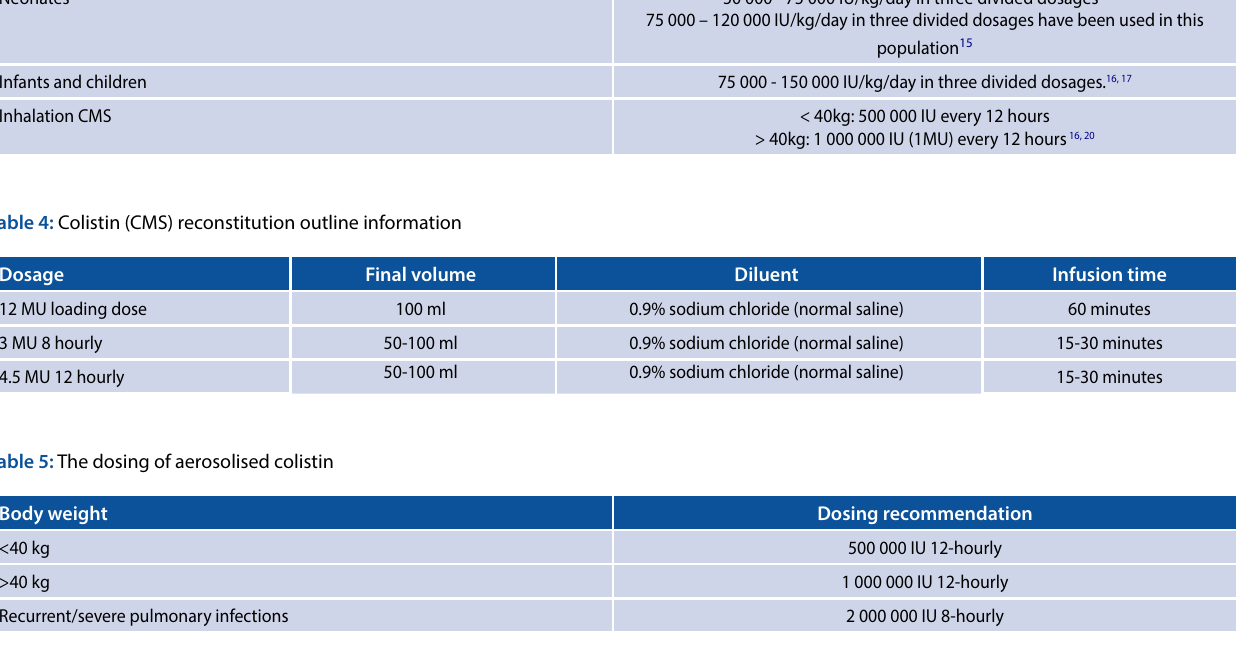
Table 3: Recommended paediatric dosages for colistin (CMS) Neonates